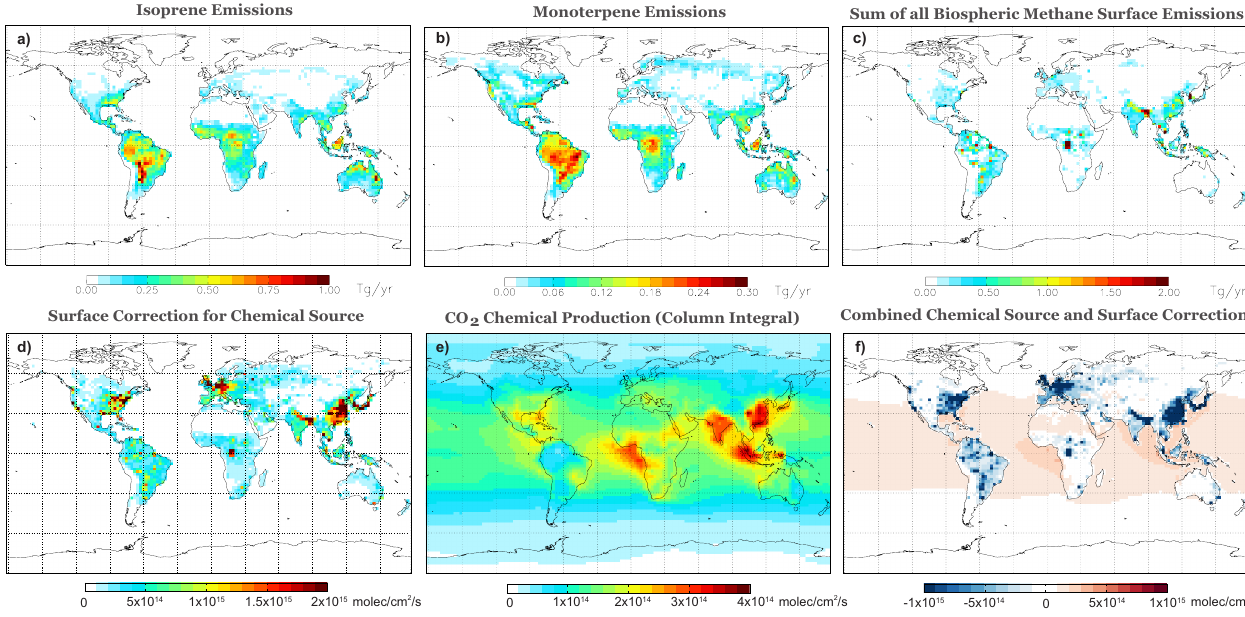
Fig. 5. Key components of the 3D chemical source and surface correction for 2006. (a) Distribution of isoprene emissions from a GEOSChem full chemistry simulation using MEGAN. (b ) Distribution of monoterpene emissions from a GEOS-Chem full chemistry simulation using MEGAN. (c) Distribution of total biospheric CH 4 emissions (wetlands, ruminants, landfills, rice, termites) from a GEOS-Chem CH 4 simulation. (d) Surface correction due to all biogenic and fossil fuel emissions to avoid double-counting emission of CO 2 precursor species (CO, CH 4 and NMVOCs) shown on a log scale. (e) Column sum of CO 2 production rates based directly on CO loss rates from a GEOS-Chem NO x -O x -hydrocarbon (full chemistry) simulation. (f) Column sum of panels (d) and (e) .